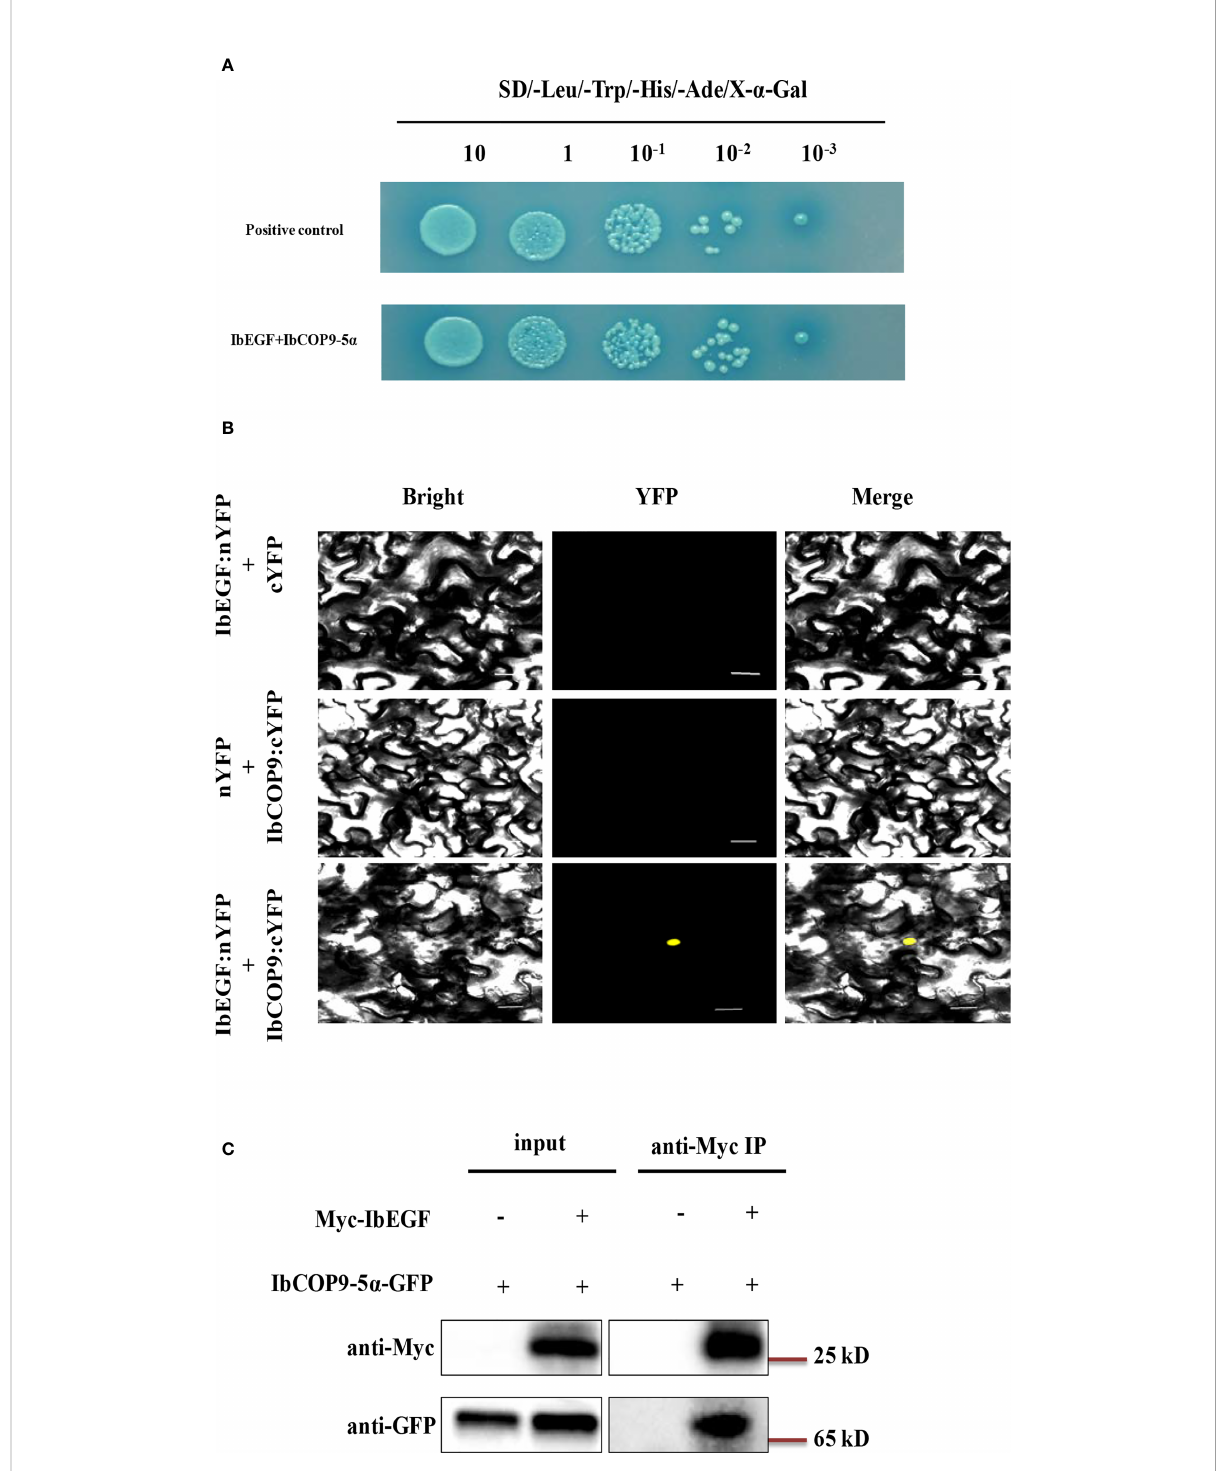
FIGURE 7 In vivo interaction between IbEGF and IbCOP9-5 a . (A) IbEGF/IbCOP9-5 a interaction in Y2H Gold cells by Y2H assay. (B) IbEGF/IbCOP9-5 a interaction in the tobacco nucleus by BiFC assay. The yellow fl uorescent protein (YFP) signals were predominantly localized in the nucleus. Bars = 20 m m. (C) IbEGF/IbCOP9-5 a interaction by the co-IP assay. Total proteins from N. benthamiana leaf cells expressing Myc-IbEGF and IbCOP9-5 a -GFP were extracted and incubated with anti-Myc magnetic beads. Proteins before (input) and after IP were detected with anti-Myc and anti-GFP